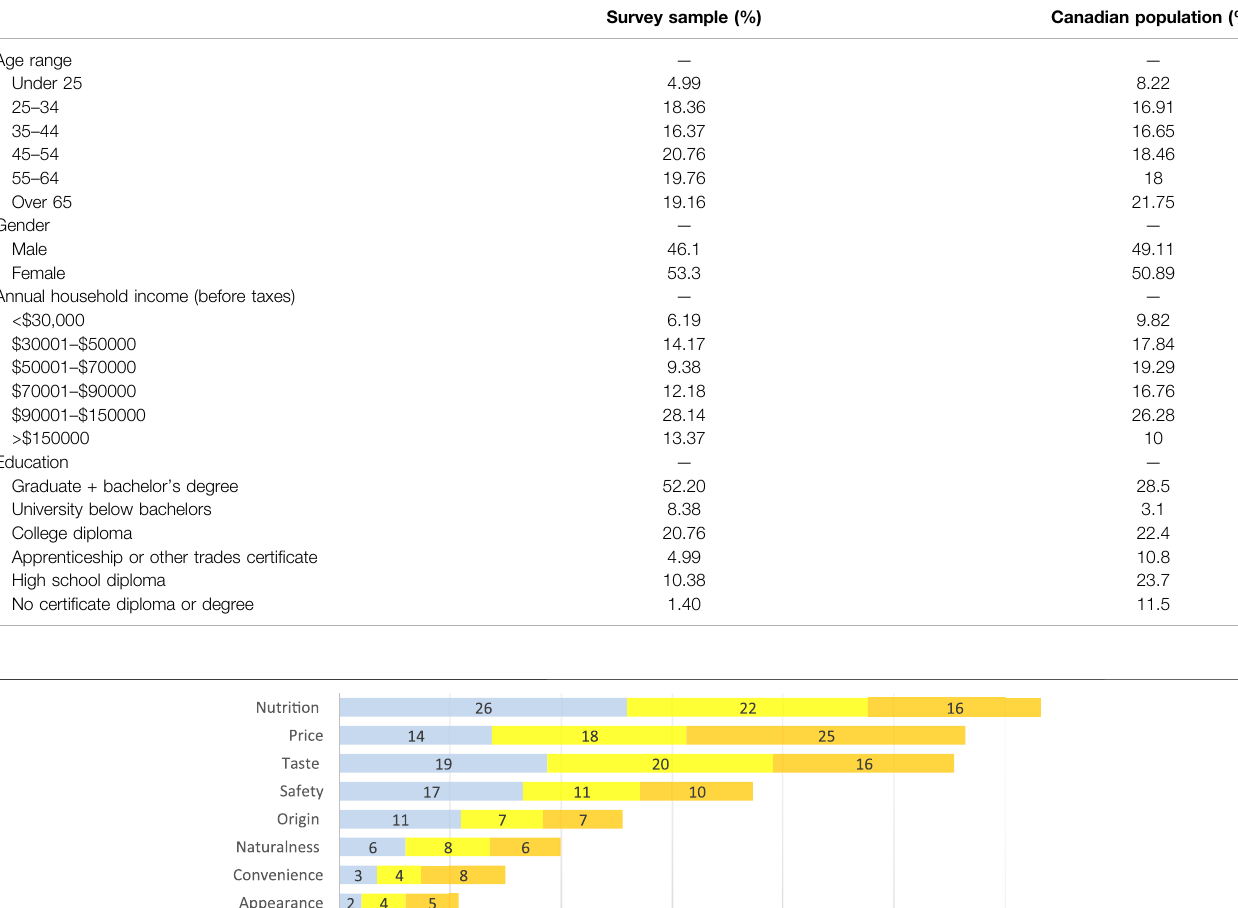
TABLE 2 | Socio-economic characteristics ( n = 497).